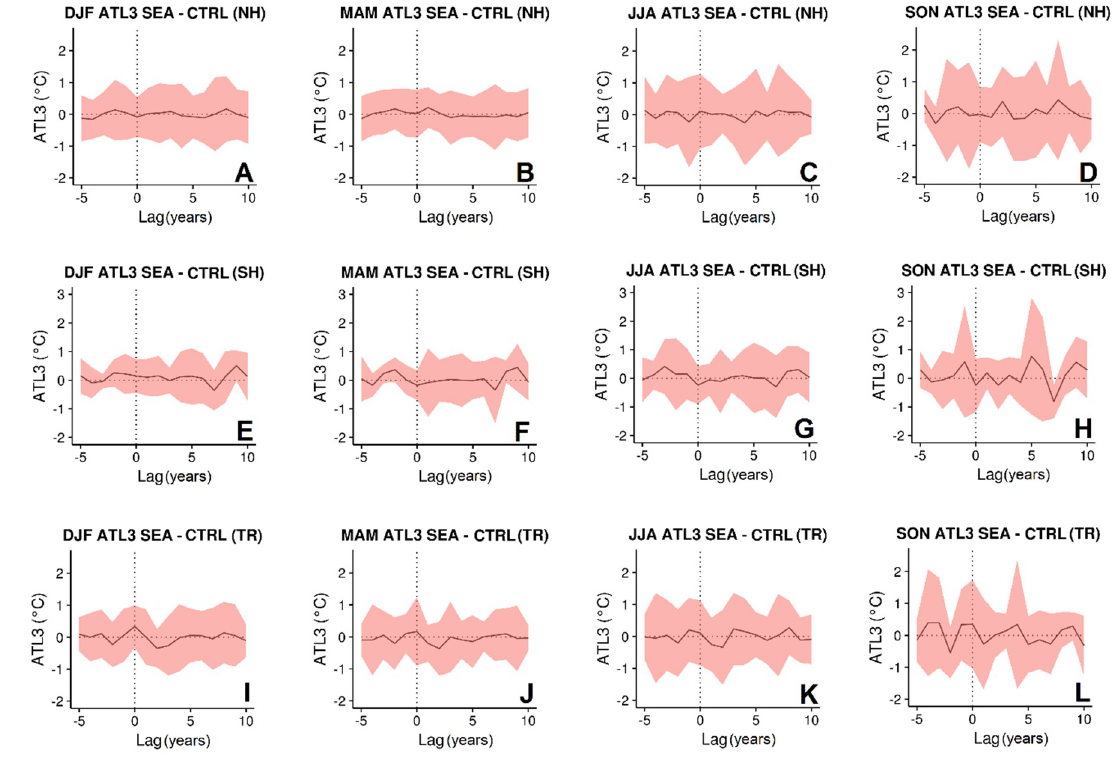
Figure 3. CTRL SEA for ATL3 SST seasonal anomalies ( ◦ C), calculated after list of volcanic eruptions in Table 1, for five years before the eruption and ten years after the eruption. Horizontal: class of the eruptions (NH—( A – D ); SH—( E – H ); and TR—( I – L )); Vertical: seasonal SEA (December to February—DJF; March to May—MAM; June to August—JJA; and September to November—SON). Dark red line corresponds to the CTRL run, and light shaded red corresponds to one standard deviation of the CTRL run.